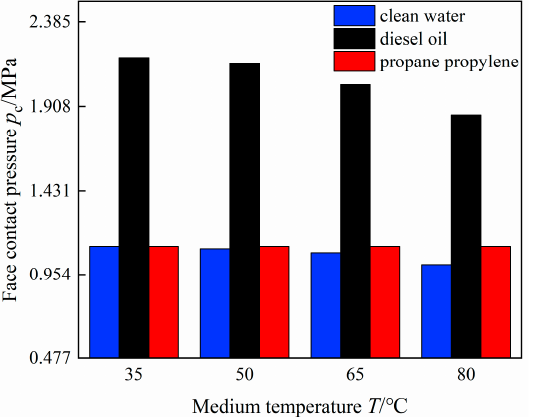
Figure 6. Influence of the medium pressure on the face contact pressure range.